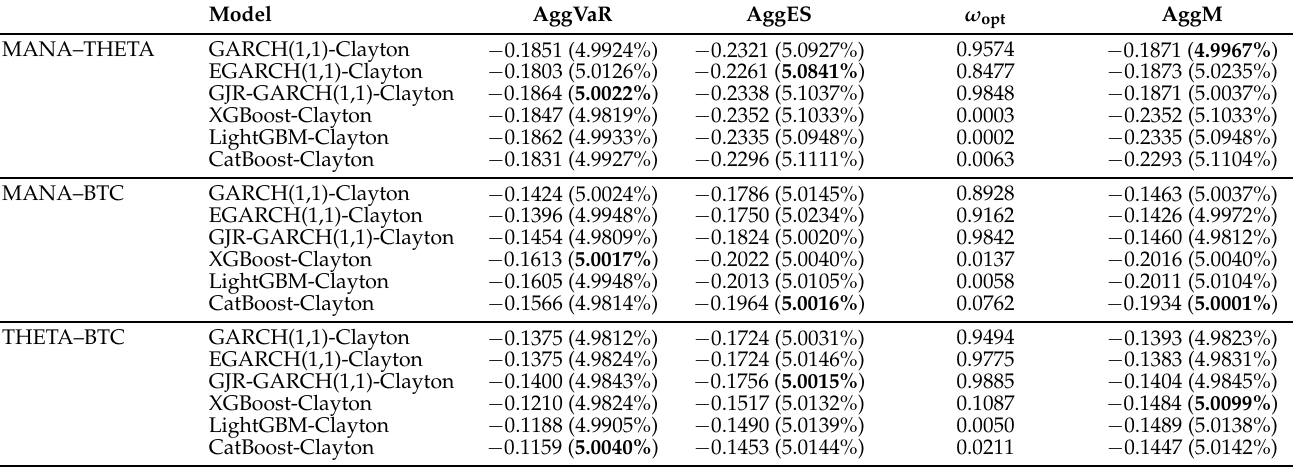
Table 8. One-step-ahead aggregate risk measure forecasts at the 5% level of significance. Model AggVaR ω